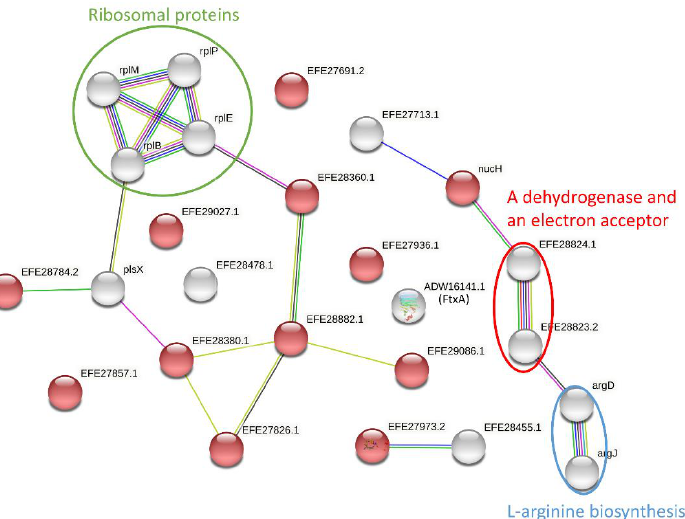
Figure 2. Predicted protein–protein interactions between EV proteins. Shown are networks established using STRING 10.5 based on the low confident score (0.15) of EV proteins (Supplementary Table S2). The interactions with high confident scores (0.9) are shown in circles. Proteins enriched for “signal” (UniProt: KW -0732) are indicated with red balls and the others with white. Colors of lines indicate different types of protein – protein interactions. Blue and purple lines indicate interac- tion determined from the curated database and experimental results, respectively. Green, red, and dark blue lines indicate predicted interactions determined from gene neighborhood, gene fusions, and gene co-occurrence, respectively. Yellow and black lines indicate interactions deduced from text mining and co-expression, respectively. 3.3. Quantification of the EV Proteins from Different F. alocis Strains To further understand the expression of these EV proteins in the ten F. alocis strains, we performed label-free quantification using ProgenesisQI and quantified 24 of 25 of the detected EV proteins. The only exception was the uncharacterized protein EFE27936.1, which was only detected in the reference strain ATCC 35896 and in strain 149A-17U (Table 1) and, therefore, might be excluded by the label-free quantification algorithm of Pro- gensisQI during the peak picking. The ANOVA test showed that the expression of 16 of the EV proteins was significantly different among ten strains ( p < 0.05) (Supplementary Table S3). In contrast, the expression levels of three of four ribosomal proteins, two en- zymes involved in L-arginine biosynthesis, two hypothetical proteins, and the type IV pilin was consistent among all strains (Supplementary Table S3). We also found that the reference strain ATCC 35896 had the highest number (five, all significantly differently ex- pressed among the ten strains) of the most abundant EV proteins (Table 2, Supplementary Table S3). On the other hand, strain 413B3-17U exhibited the highest number (five, four of which were significantly differently expressed) of the least abundant EV proteins (Table 2, Supplementary Table S3). Table 2. EV protein abundancies in the ten F. alocis strains. The numbers of most or least abundant EV proteins in each F. alocis strain, as determined by label-free quantification proteomics, are indi- cated. F. alocis Strain